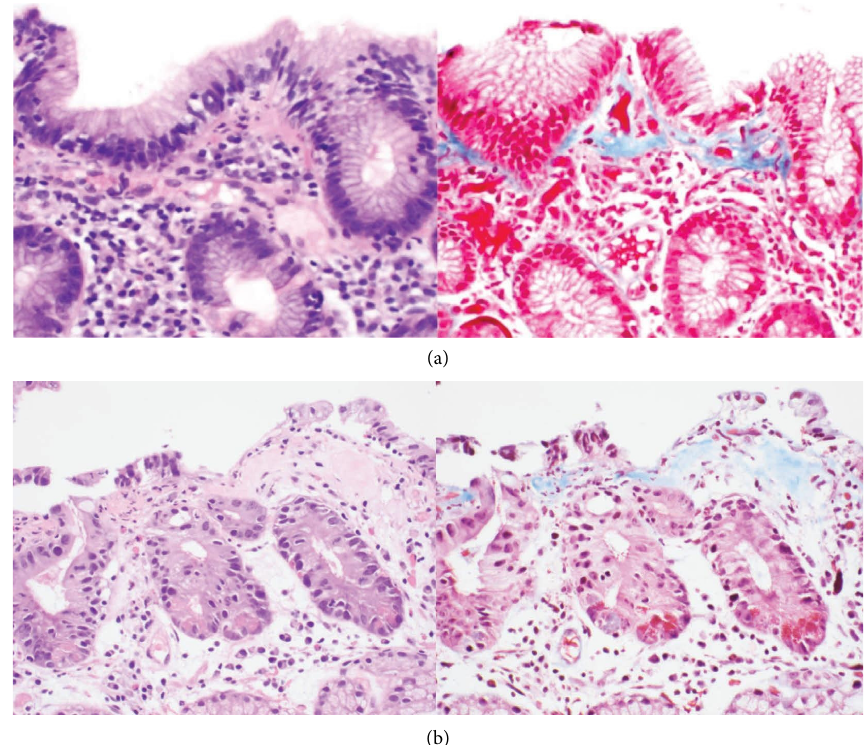
Figure 2: Hematoxylin and eosin staining of the patients’ gastric biopsies demonstrates reactive lymphoid infltrates and prominent bands of collagen within the lamina propria ((a) case 1; (b) case 2), 400x magnifcation. Masson’s trichrome staining highlights the collagenous thickening > 10 μ m, 400x